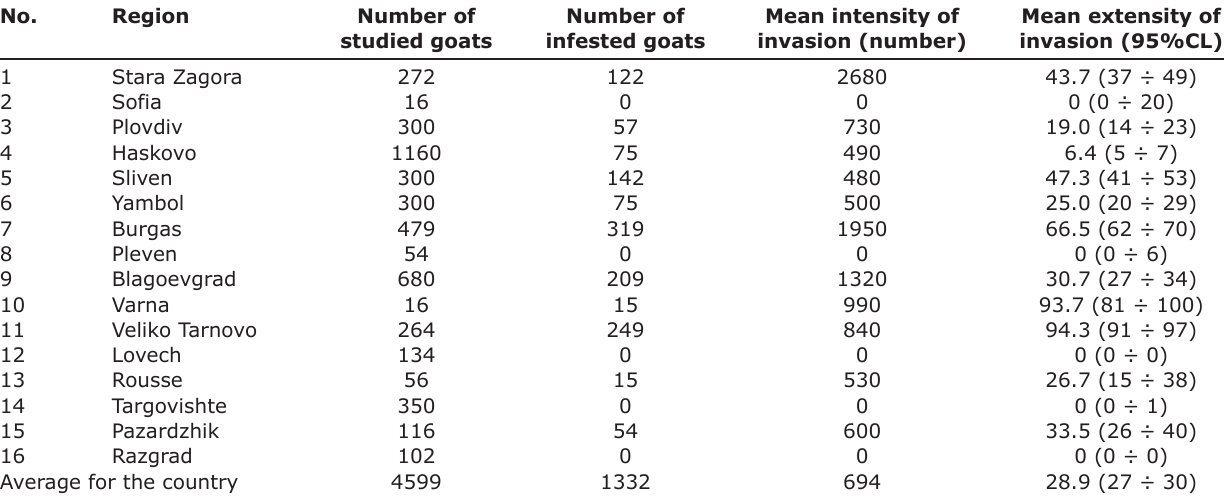
Table-5: Regional distribution of the mean intensity and mean extensity of invasion with B. caprae in domestic goats. No.